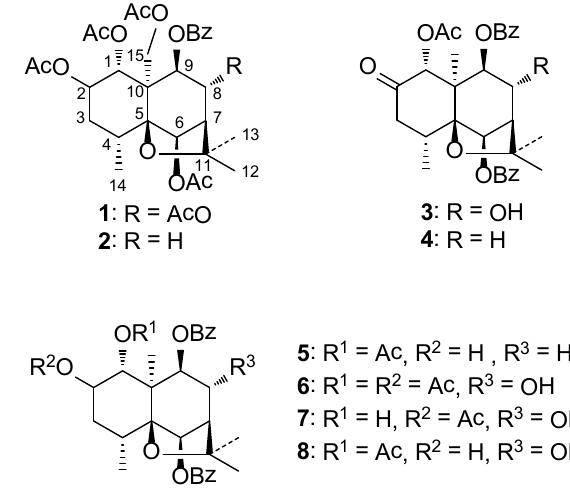
Figure 1. Structures of isolated compounds from P.